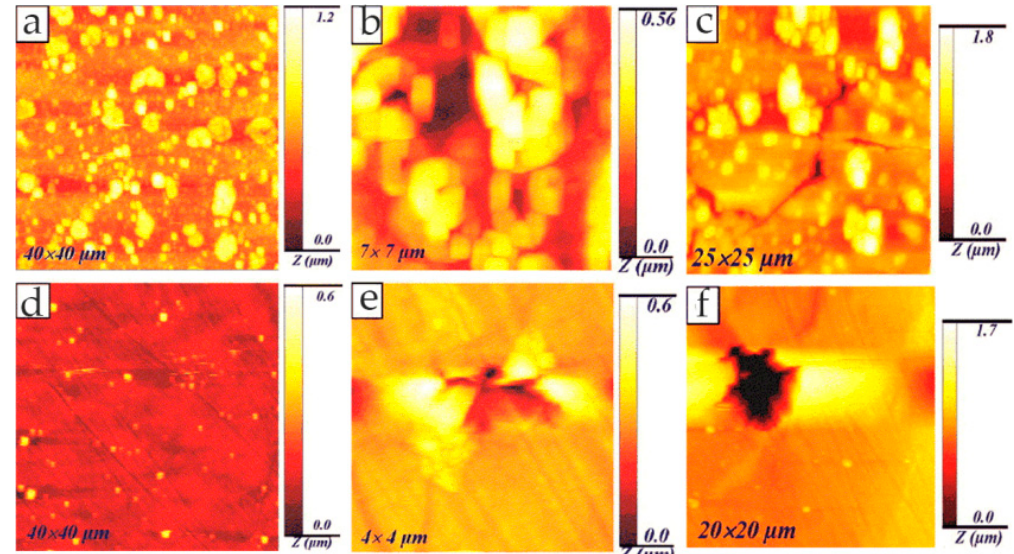
Figure 23. In situ AFM images of ( a ) EN AW-3003 and ( b ) Al–Mn–Si–Zr, after two days; ( e ) EN AW-3003 and ( f ) Al–Mn–Si–Zr, after 3.5 days in Sea Water Acetic Acid Test (SWAAT) solution of pH 4. ( c , d ) Magnified images of the framed areas of ( a , b ), respectively. Adapted with permission from Reference [58]; copyright 2007 Elsevier Ltd.